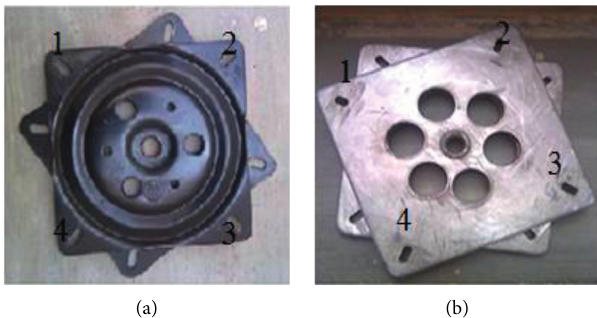
Figure 2: Swivel plate with four location points: (a) A3 steel and (b) Mg Table 4: Dimensions and Weight of Specimen for flexural strength analysis.